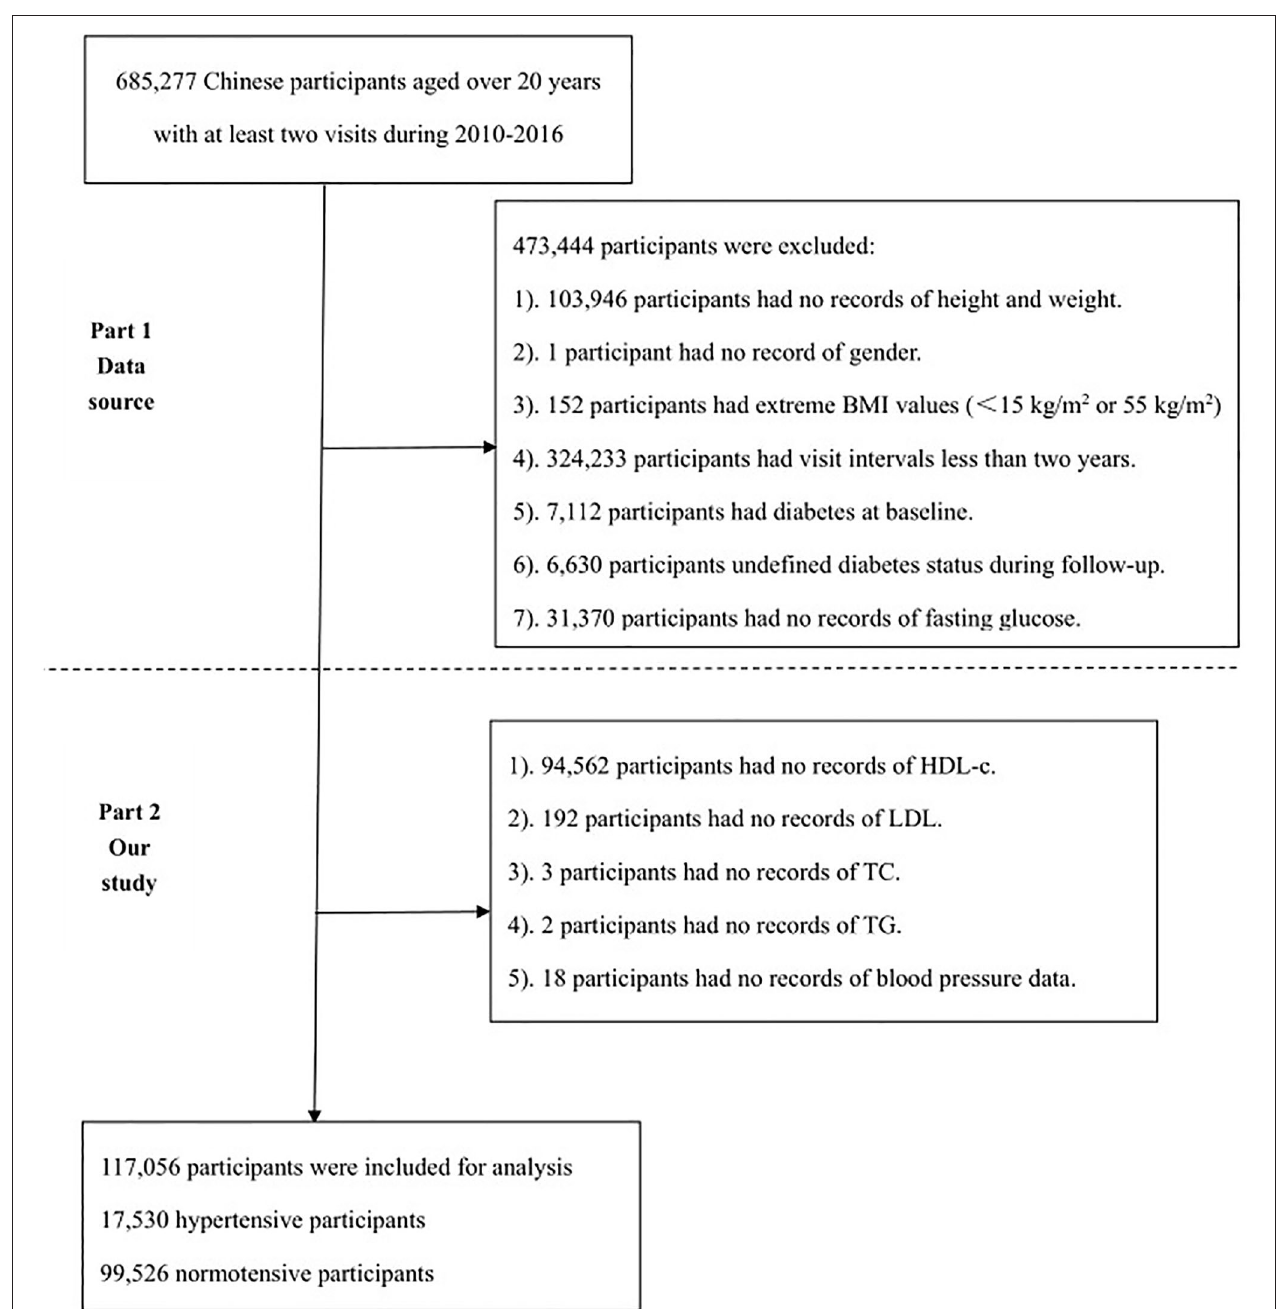
FIGURE 1 | The flowchart of the study. The first part is the flowchart of the original study and the second part is the flowchart of the current study.